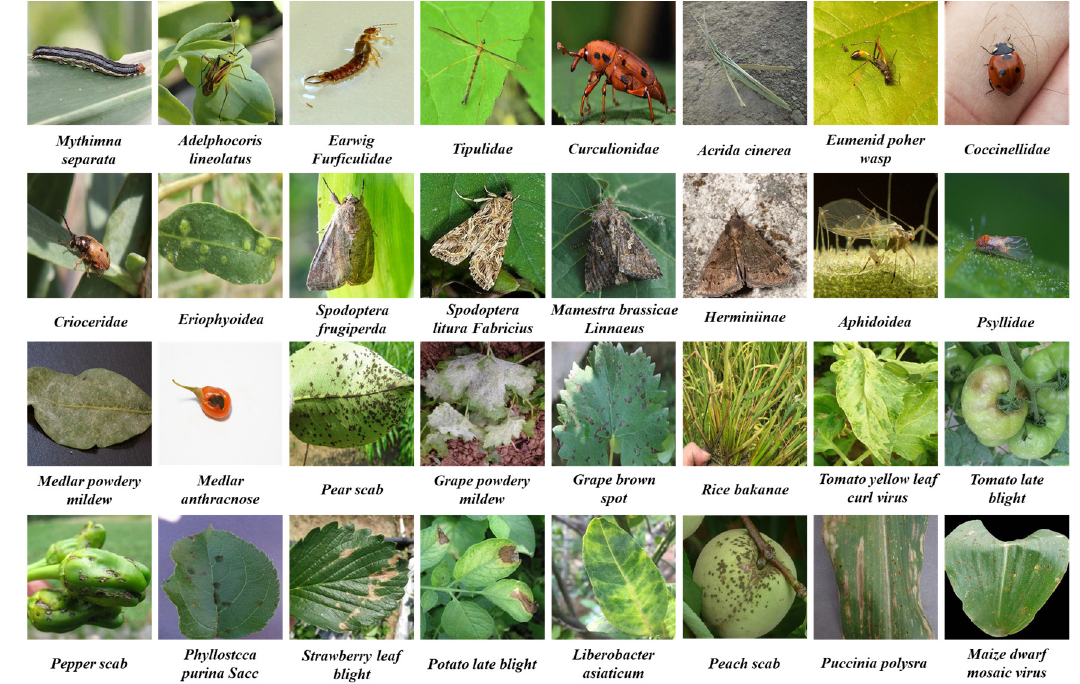
Figure 3. Image samples of pests and diseases in CropDP ‐ 181 Dataset.